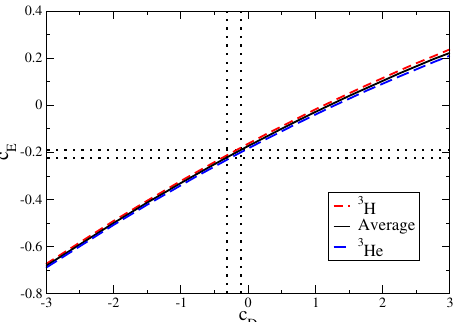
Fig. 3. (Color online.) c D - c E trajectories fitted to reproduce 3 H and 3 He experimental b.e. The dotted lines show the region for D D E E | is within the ± 0 . 54% error-bars. Fig- E A E A / which | 1 − 1 1 th emp ure taken from